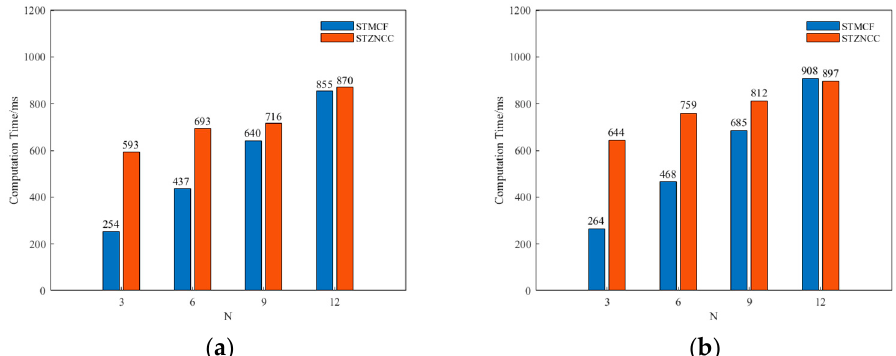
Figure 12. Computation time comparison between STZNCC and STMCF by projecting N speckle patterns: ( a ) a dumbbell gauge; ( b ) a plastic human face mask.